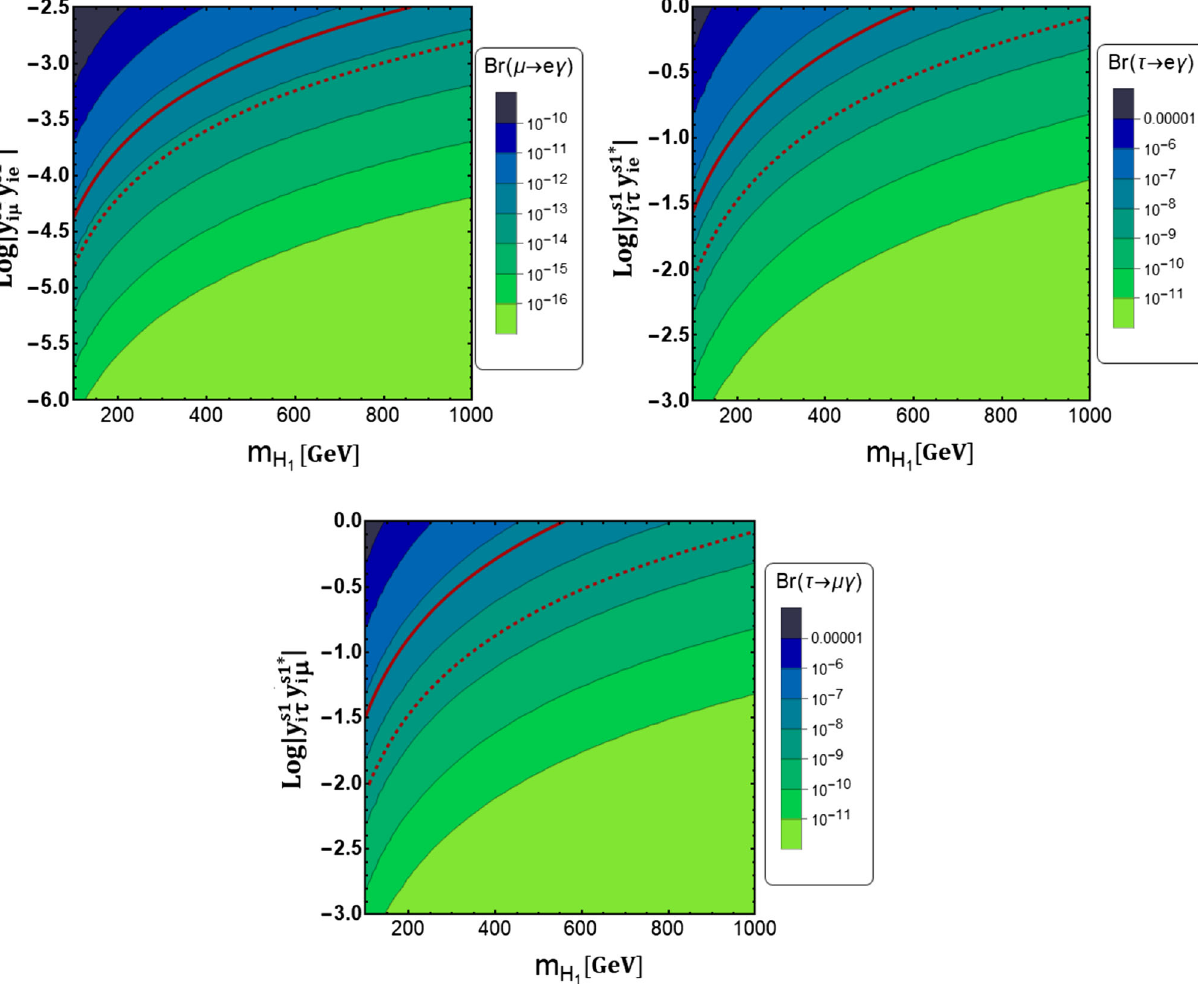
Fig. 6 Contour plot for branching ratio predictions for the processes: Dirac neutrino mass model. Red solid lines indicate the current bounds μ → e + γ (top left), τ → e + γ (top right) and τ → μ + γ (bottom) on branching ratios and red dashed lines indicate the future projected ) and Yukawa plane in simplest one-loop as a function of mass ( m H bounds on the branching 1